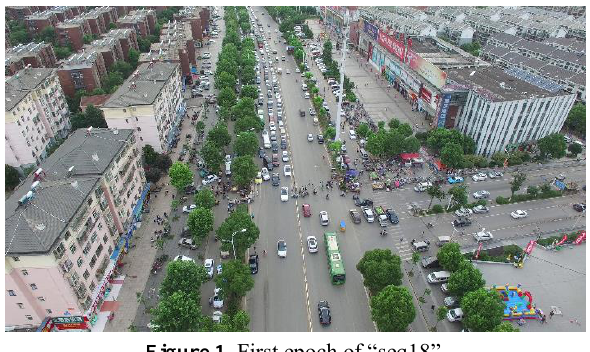
Figure 1 . First epoch of “seq18”.